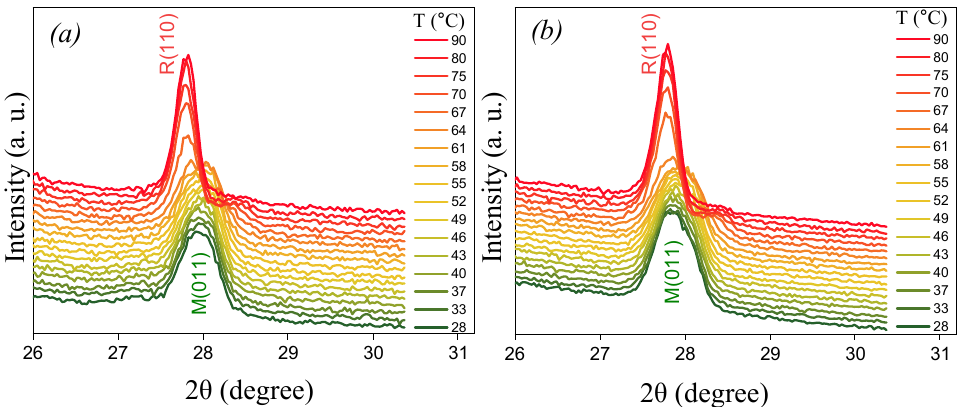
Figure 2. Temperature-dependent GIXRD data of ( a ) VO 2 thin film sample and ( b ) AZO/VO 2 thin film sample measured during heating cycle.